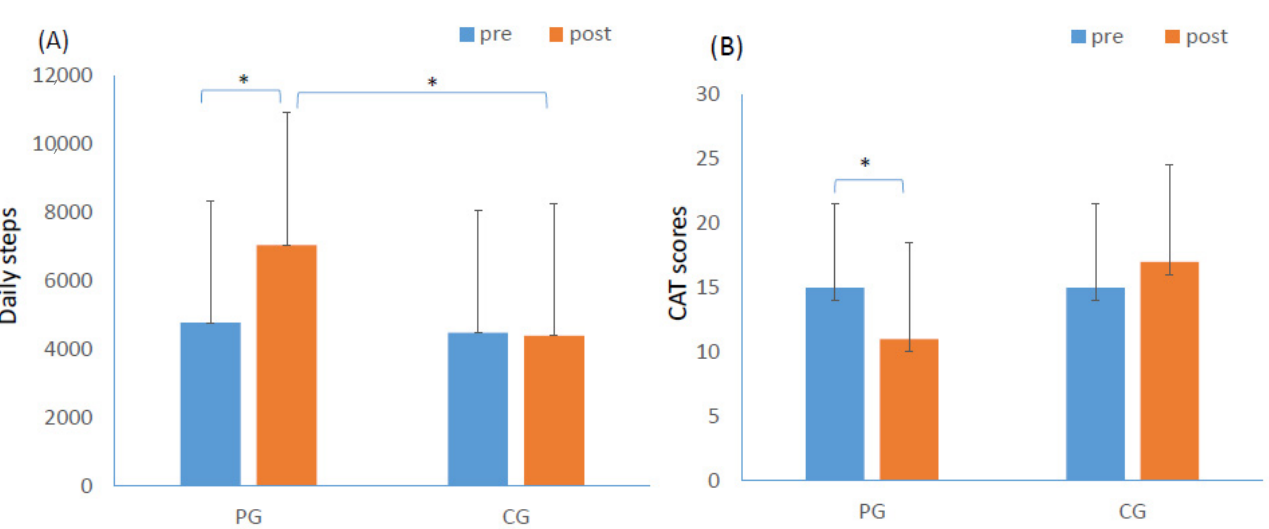
Figure 2. Comparisons of daily steps ( A ) and CAT scores ( B ) within subjects in PG and CG. *: p < 0.05.